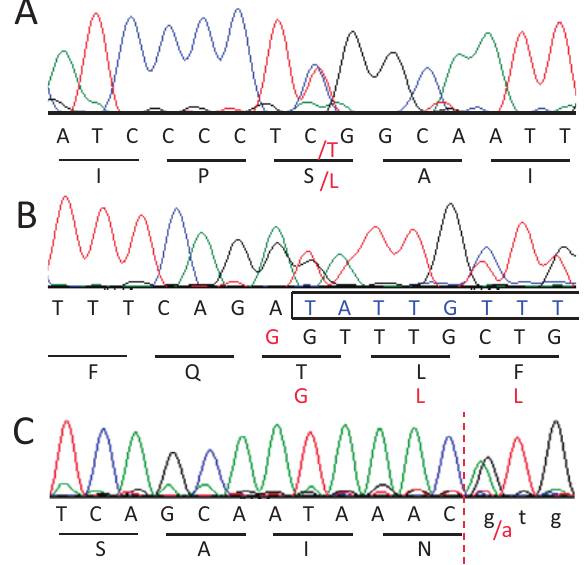
Fi g ure 2 Electrophero g rams of San g er seq u encin g . The c.278C>T is commonl y obser v ed ( A ). Both c.337_353delinsG ( B ) and c.423+1G>A ( C ) are sho w n as heteroz yg o u